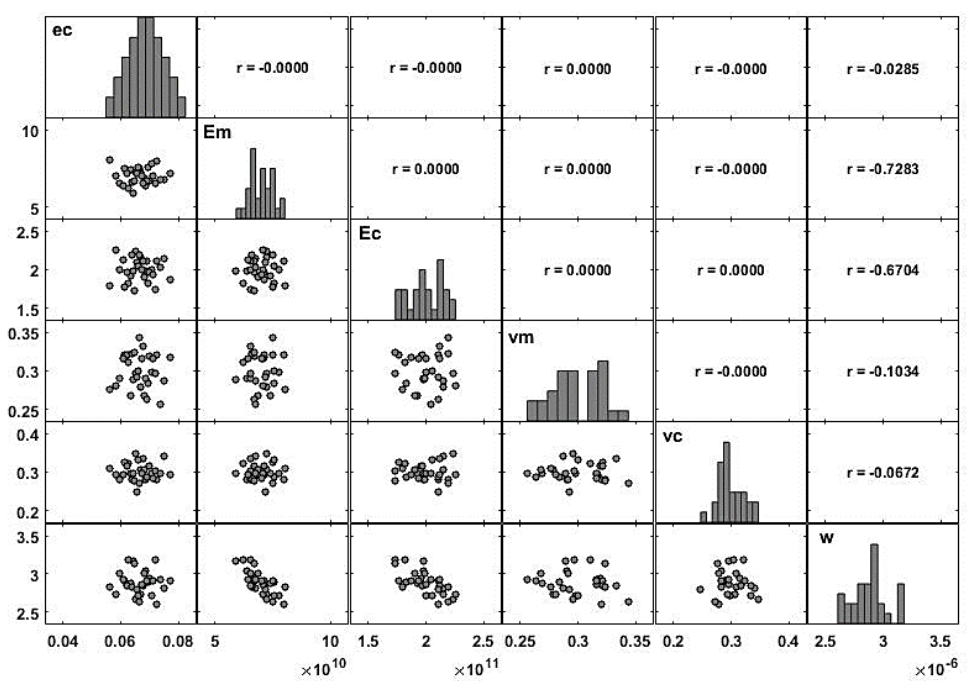
Figure 3. Matrix plot of the modeling parameters (inputs and output): case 3.2.1—Thinner core. Only between the maximum deflection and the input parameters do non-null correlations